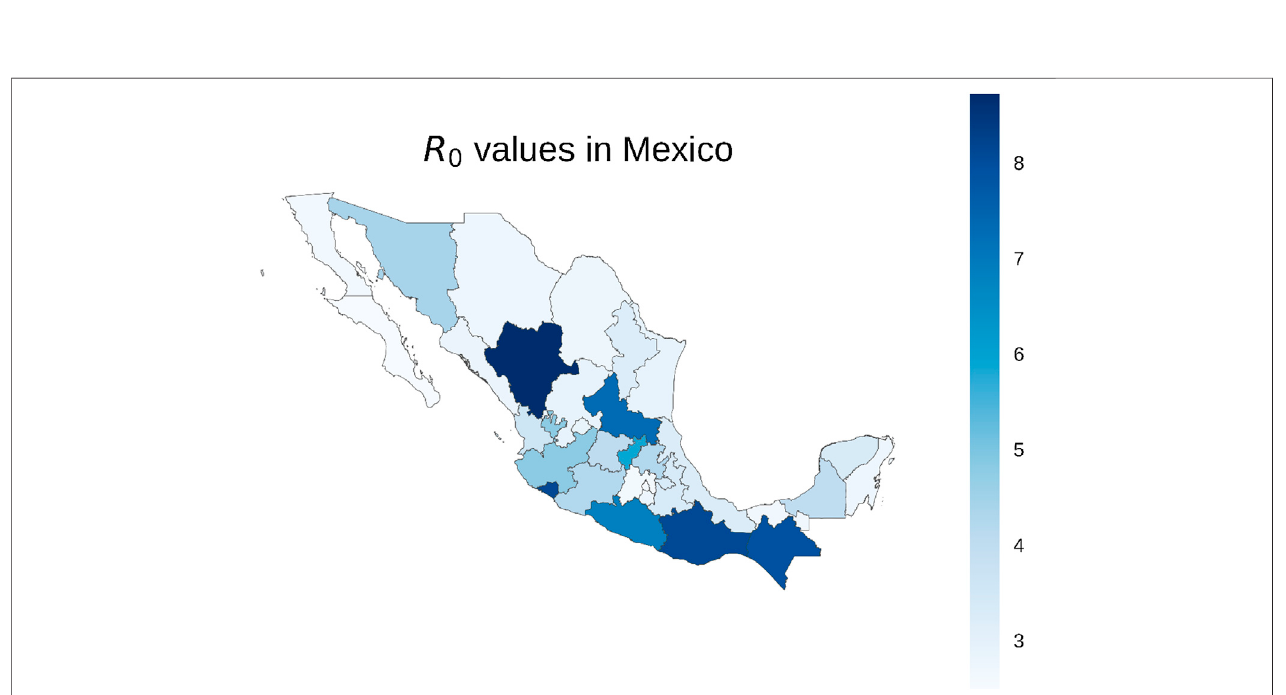
FIGURE 2 | Reproductive number ( R 0 ) for all Mexico states obtained from the model fi ts up to June 25, 2020.